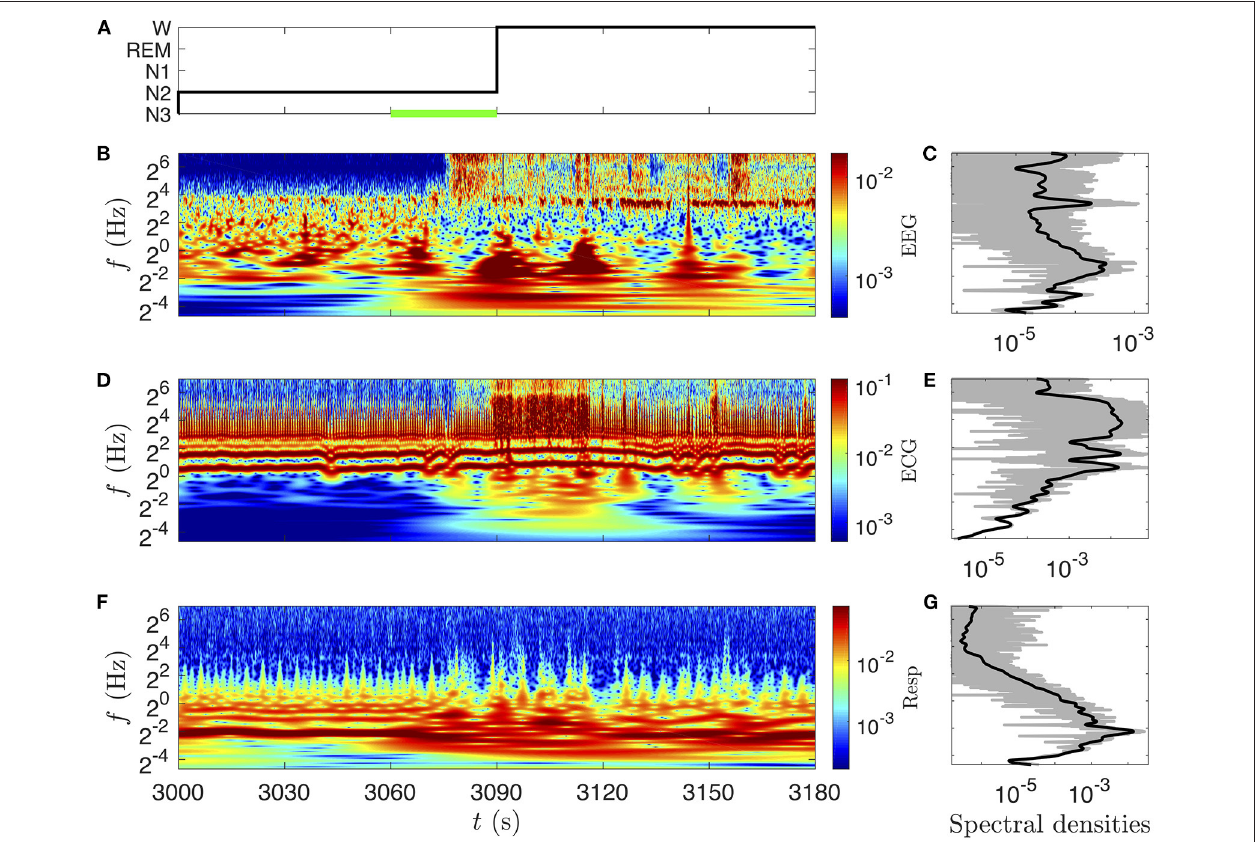
FIGURE 4 | CWT’s amplitude (twice its modulus) (B,D,F) and spectral densities (C,E,G) of the signals presented in Figure 3 . (A) Hypnogram. (B) amplitude of the EEG (C3-O1) (color bar in mV) and (C) power log-frequency density (in mV 2 ). (D) Amplitude of the ECG (color bar in mV) and (E) power log-frequency density (in mV 2 ). (F) Amplitude of the nasal respiration signal (color bar in l s − 1 ) and (G) power log-frequency density [in (l s − 1 ) 2 ]. The CWTs are computed with the Grossmann wavelet · · f of quality factors Q 10, sufficient to appreciate the frequency localization of the α EEG waves. The corresponding power log-frequency density S x ( f ) is estimated = | | either directly from the squared Fourier transform (thin gray line) or from the CWT (Equation 6), (thick black